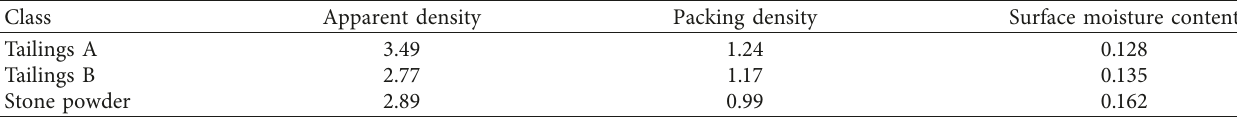
Table 1: Physical properties of the tailings and the stone powder.